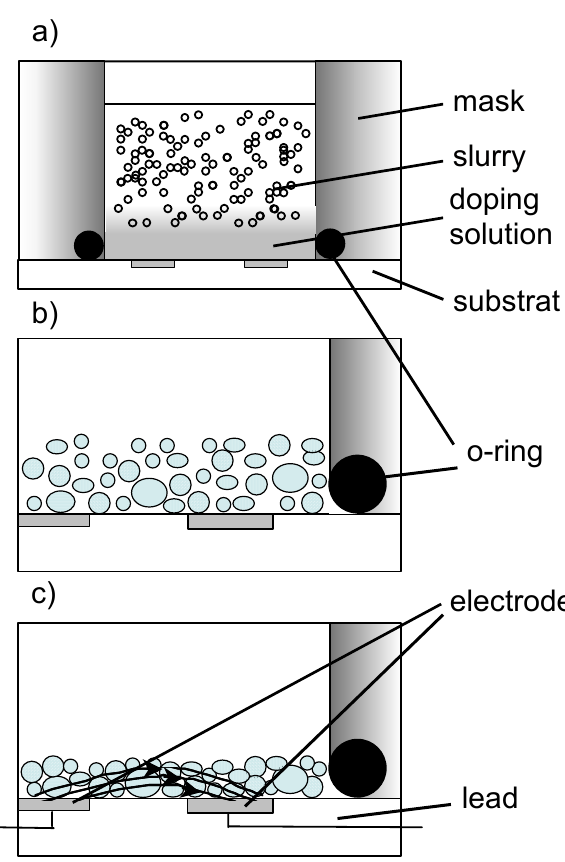
Figure 2. Sequence of the film formation in the synthesis reactor a) after filling in the cavity of the mask, b) after drying c) after calcination.